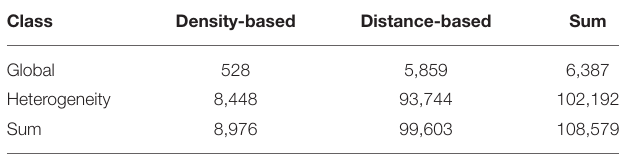
FIGURE 2 | Example analysis results. For the slide with object data visualized above, the table shows six example features computed by our analysis. TABLE 1 | Number of features and percentages of different classes